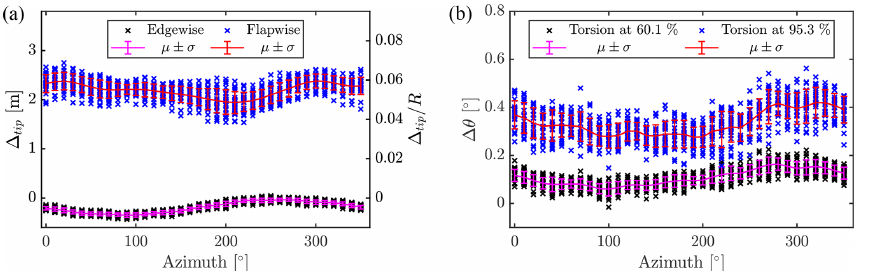
Figure 14. (a) Tip displacements flap- and edgewise. (b) Blade torsional deformation at 60.1 and 95.3% blade length. Crosses represent instantaneous realizations.